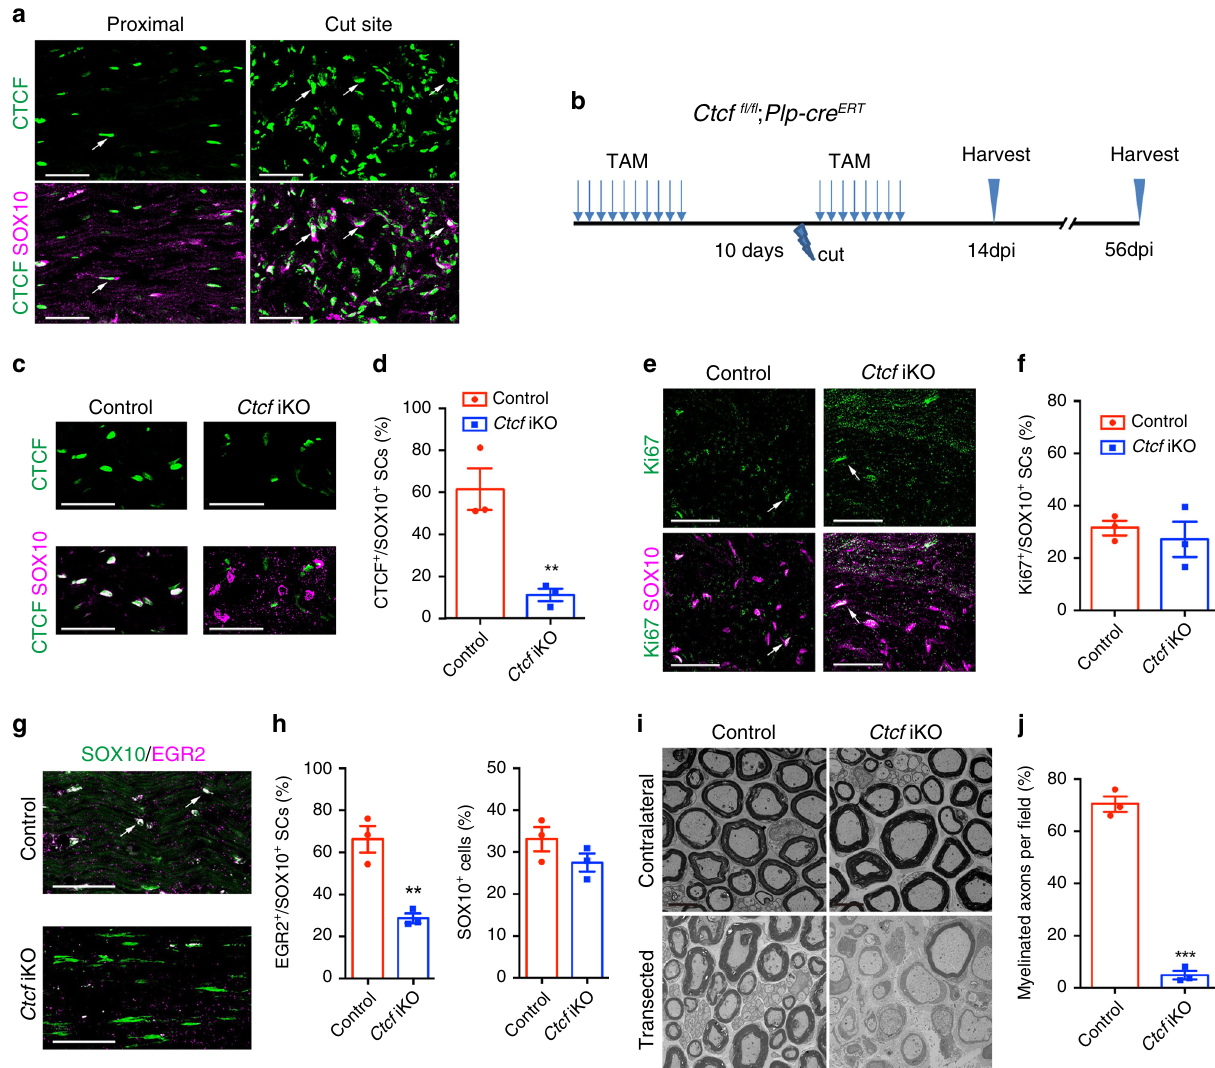
Fig. 5 CTCF is required for SC differentiation during nerve repair. a Immunolabeling for CTCF and SOX10 in uninjured (proximal) and regenerating region of sciatic nerves of control mice at 14 dpi ( n = 3 animals/genotype). Arrows indicate SOX10 + /CTCF + SCs. Scale bars: 50 μ m. b A diagram showing the nerve transection scheme. Mice were treated with TAM via i.p. for 10 days, after 10 days, nerves were cut, and mice were then given TAM for 8 days, and nerves were analyzed at dpi 14 and 56. c Immunolabeling for CTCF and SOX10 in regenerating regions of control and Ctcf iKO sciatic nerves 14 dpi ( n = 3 animals/genotype). Scale bars: 50 μ m. d Proportion of CTCF + SCs in the regenerating regions of 14 dpi control and Ctcf iKO sciatic nerves ( n = 3 animals/ genotype). P = 0.0083. e Immunolabeling for Ki67 and SOX10 in the regenerating regions of 28 dpi control and Ctcf iKO sciatic nerves ( n = 2 animals/ genotype). Arrows indicate representative SOX10 + /Ki67 + SCs. Scale bars: 50 μ m. f Proportion of Ki67 + SCs in the regenerating regions of 14 dpi control and Ctcf iKO sciatic nerves ( n = 3 animals/genotype). P = 0.58. g Immunolabeling of SOX10 and EGR2 in the regenerating regions of 14 dpi control and Ctcf iKO sciatic nerves ( n = 3 animals/genotype). Arrows indicate representative SOX10 + /EGR2 + SCs. Scale bars: 50 μ m. h Proportion of (left) EGR2 + over SOX10 + cells and (right) SOX10 + cells in the regenerating regions of 14 dpi control and Ctcf iKO sciatic nerves ( n = 3 animals/genotype). P (left) = 0.005, P (right) = 0.19. i EM images of transverse sections of control and Ctcf iKO 8 weeks after transection ( n = 3 animals/genotype). Scale bar: 6 μ